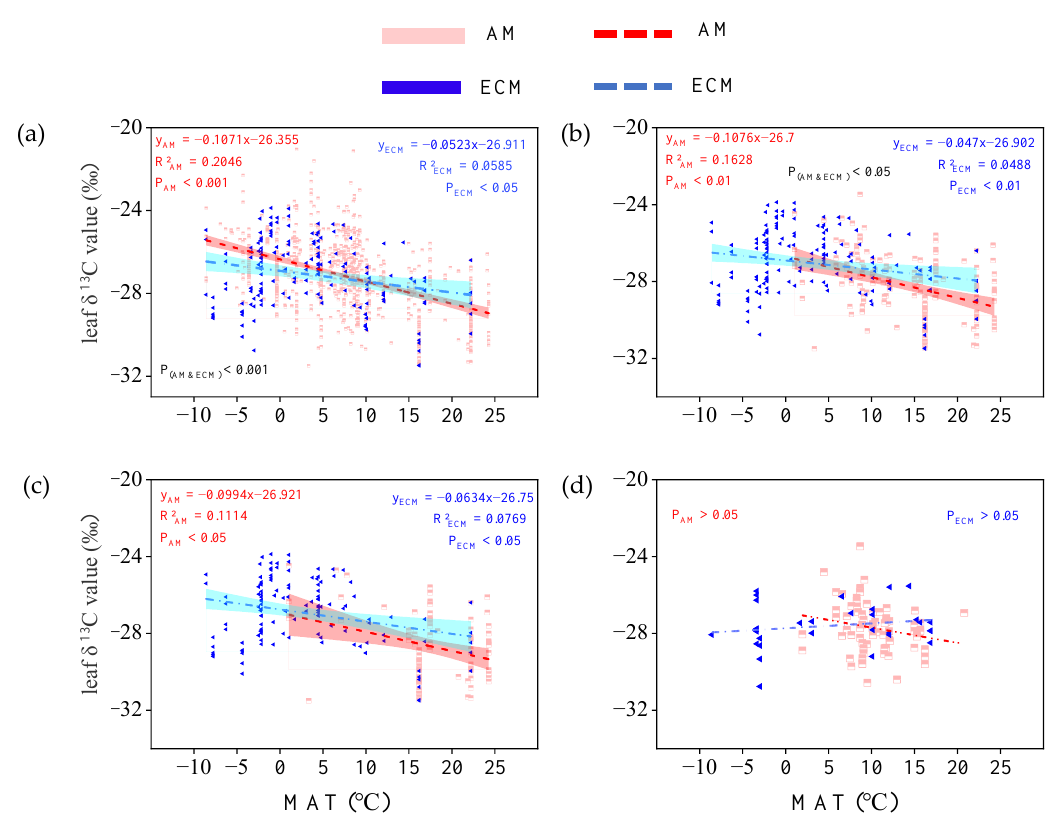
Figure 5. The relationship between leaf δ 13 C in AM plants and ECM plants with different life forms and mean annual temperature (MAT, ◦ C). ( a ) Total plants, include all plants in the database without distinguishing their life forms. ( b ) Trees, only contain all the tree species in the database. ( c ) Evergreen trees, only contain all evergreen trees of the tree species. ( d ) Deciduous trees, only contain all deciduous trees of the tree species. The red broken line means AM, the blue broken line means ECM. The red and cyan bands represent, respectively, the prediction intervals of AM and ECM plants. P( AM and ECM ) represents the significant difference in the slope of the two regression